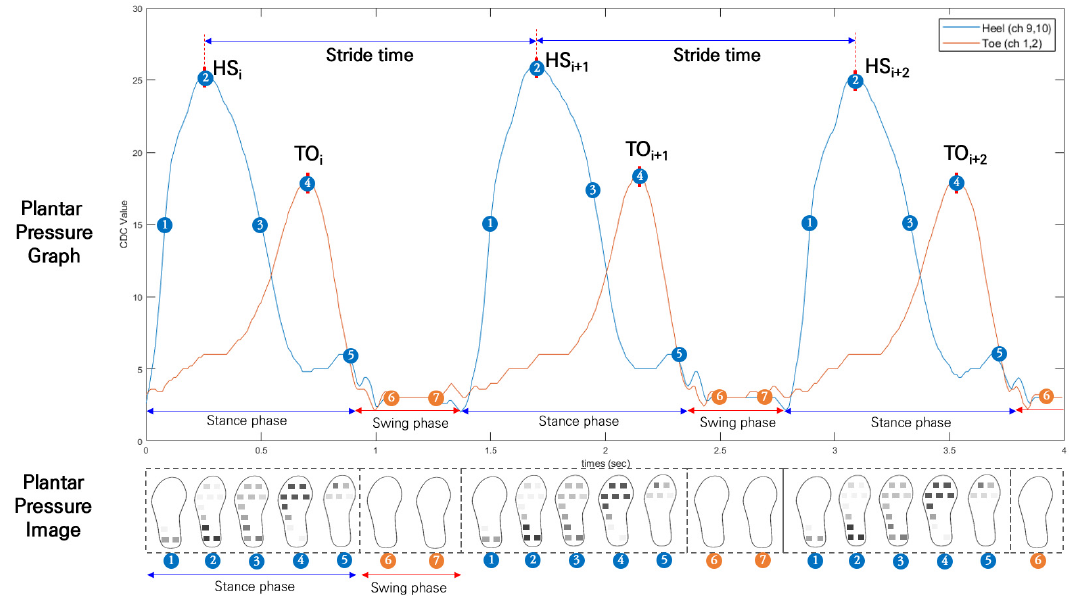
Figure 6. Extraction of stride time, stance phase, and swing phase from I-TCP data.